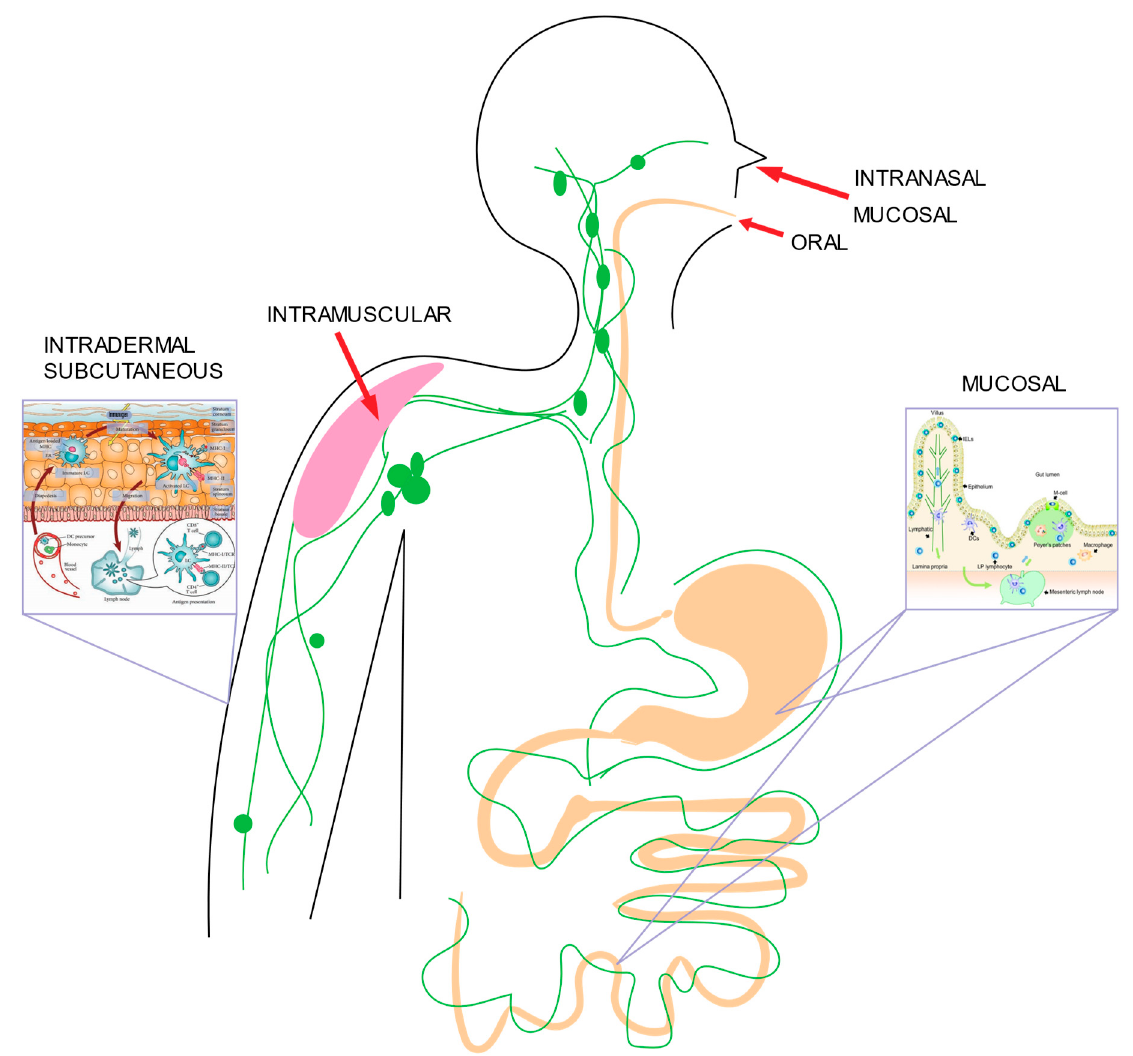
Figure 1. Vaccine Delivery Routes (insets (L,R): [71,72]).